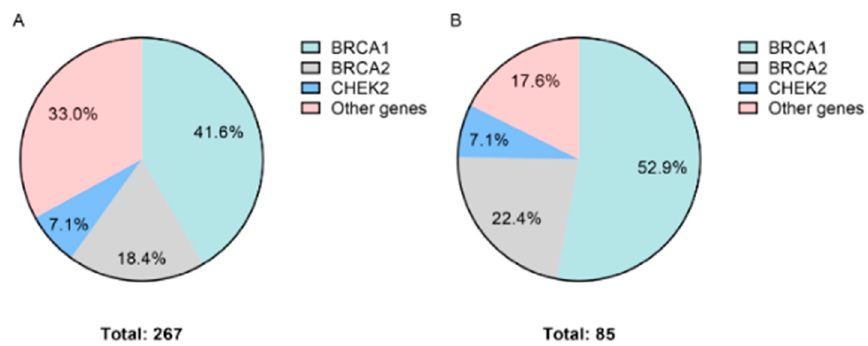
Figure 2. Distribution of genetic variants. ( A ) Breast cancer. ( B ) Ovarian cancer.